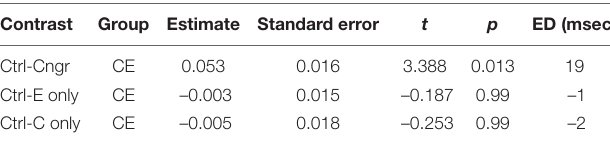
TABLE 9 | Results of post hoc , within-group tests of RTs for congruent, English-only, and Chinese-only items relative to the control items for Chinese–English